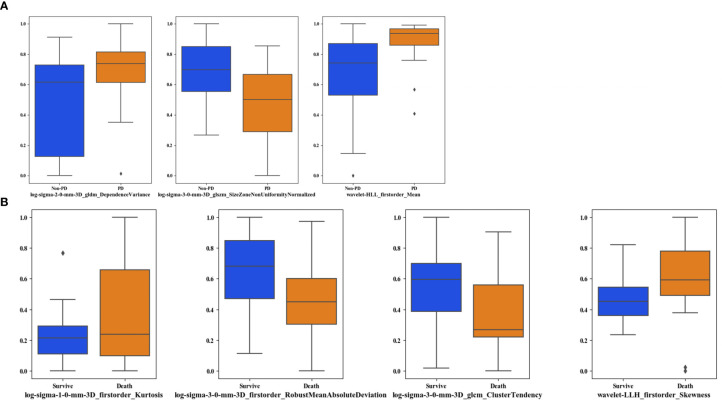
Boxplots of the frequently selected imaging features in the LOOCV process. (A) shows the imaging features selected in PFS prediction process, (B) shows the imaging features in OS prediction process.